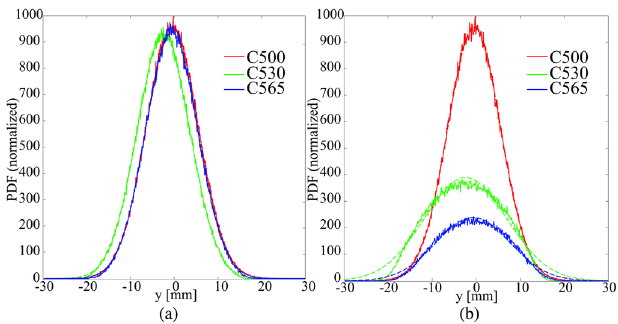
FIG. 19. The simulated vertical profiles with uncorrected COD, without (a) and with space charge (b). The dashed lines are the Gaussian